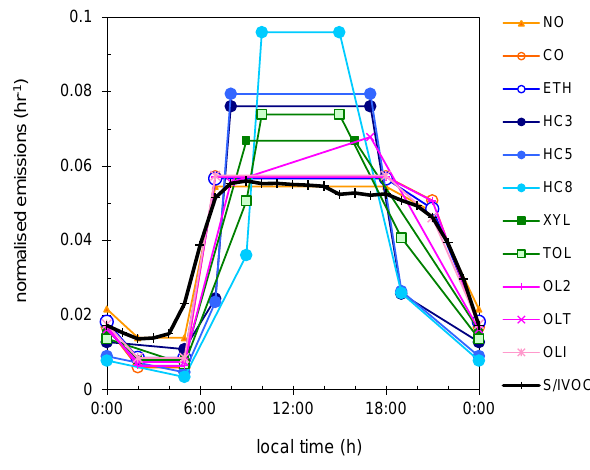
Fig. 2. Diurnal cycles of prescribed emission rates, by lumped chemical group (see Table 2 for group names and constituents). Emissions are normalized in this figure such that the daily sum of the hourly emissions for each species is unity. The model interpo- lates linearly between input data points (indicated by